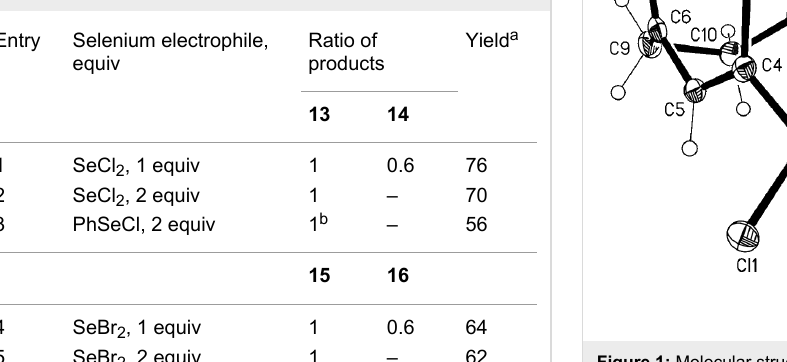
Table 2: Addition reactions to 4,13-bis(propyn-1-yl)[2.2]paracyclo- phane 12 .